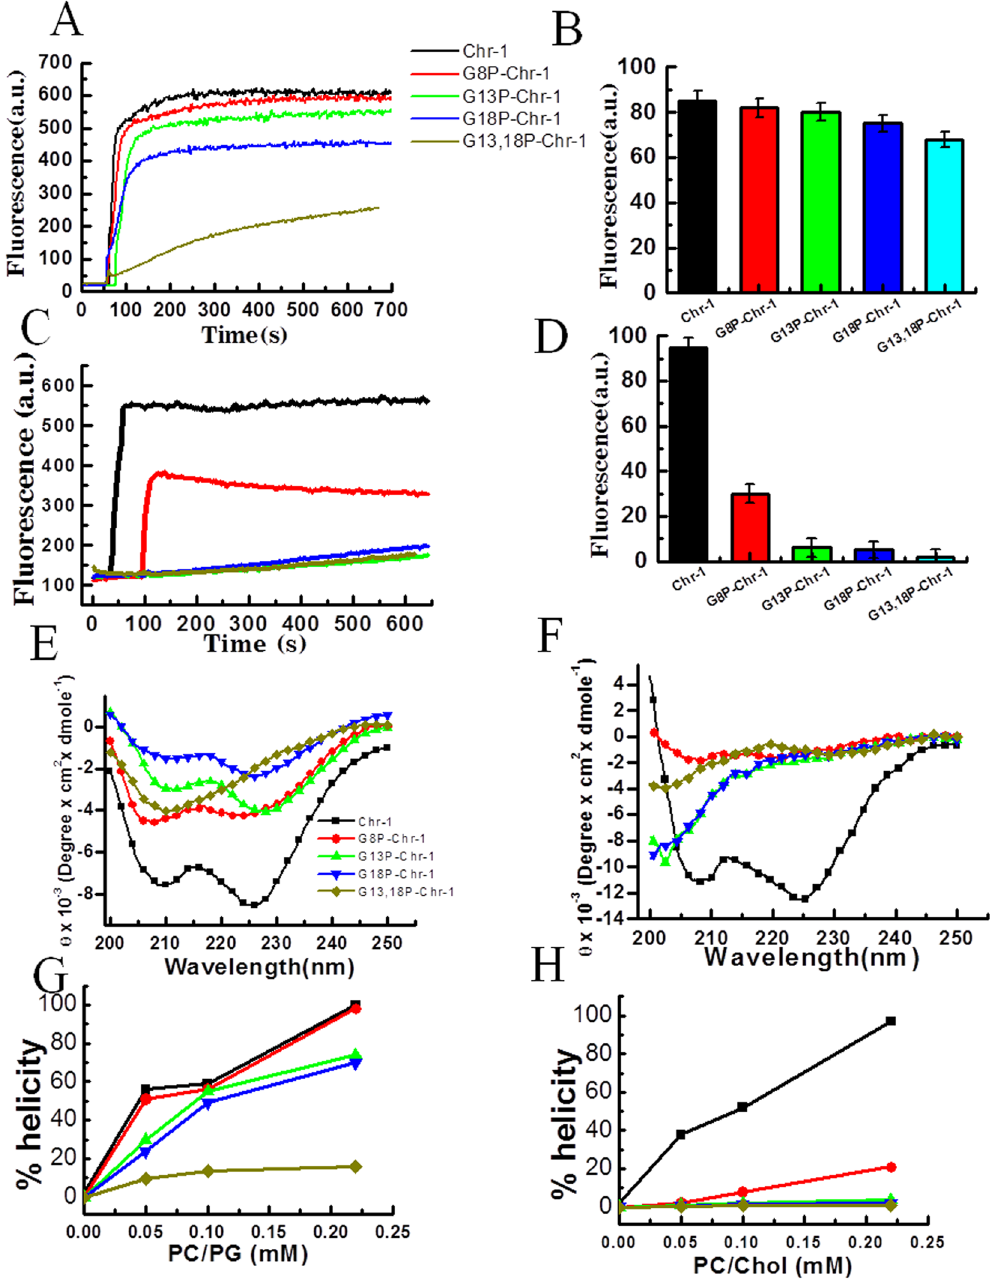
Figure 3. Determination of the diffusion potential and estimation of secondary structures of Chrysophsin-1 and its variants in lipid vesicles of different compositions. ( A ) Representative fluorescence profiles for different peptide- induced depolarization of PC/PG [3:1 (w/w)] vesicles at 8 μ M concentration for each of the peptides. ( B ) Shows the percent fluorescence recovery in [PC/PG 3:1 (w/w)]. ( C ) Represents fluorescence profiles for peptide-induced depolarization of PC/Chol [(8:1(w/w)] vesicles at 15 μ M concentration for each of these peptides. ( E and F ) Show the CD spectra of Chrysophsin-1 and its variants in PC/PG and PC/Chol lipid vesicles respectively at 25 μ M concentration of each peptide. ( G and H ) Depict the increment in the helicity of the peptides with increasing concentrations of PC/PG and PC/Chol lipid vesicles respectively. Percent helicity was calculated by the Secondary Structure Estimation (SSE) software of JASCO J-1500 Spectrometer. Symbols as indicated in ( A